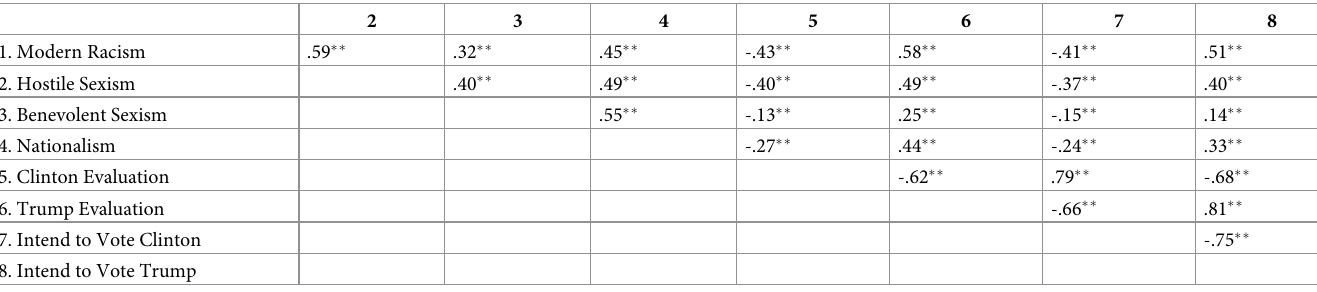
Table 2. Zero-order correlations among measures for participants who intended to vote at Time 1.